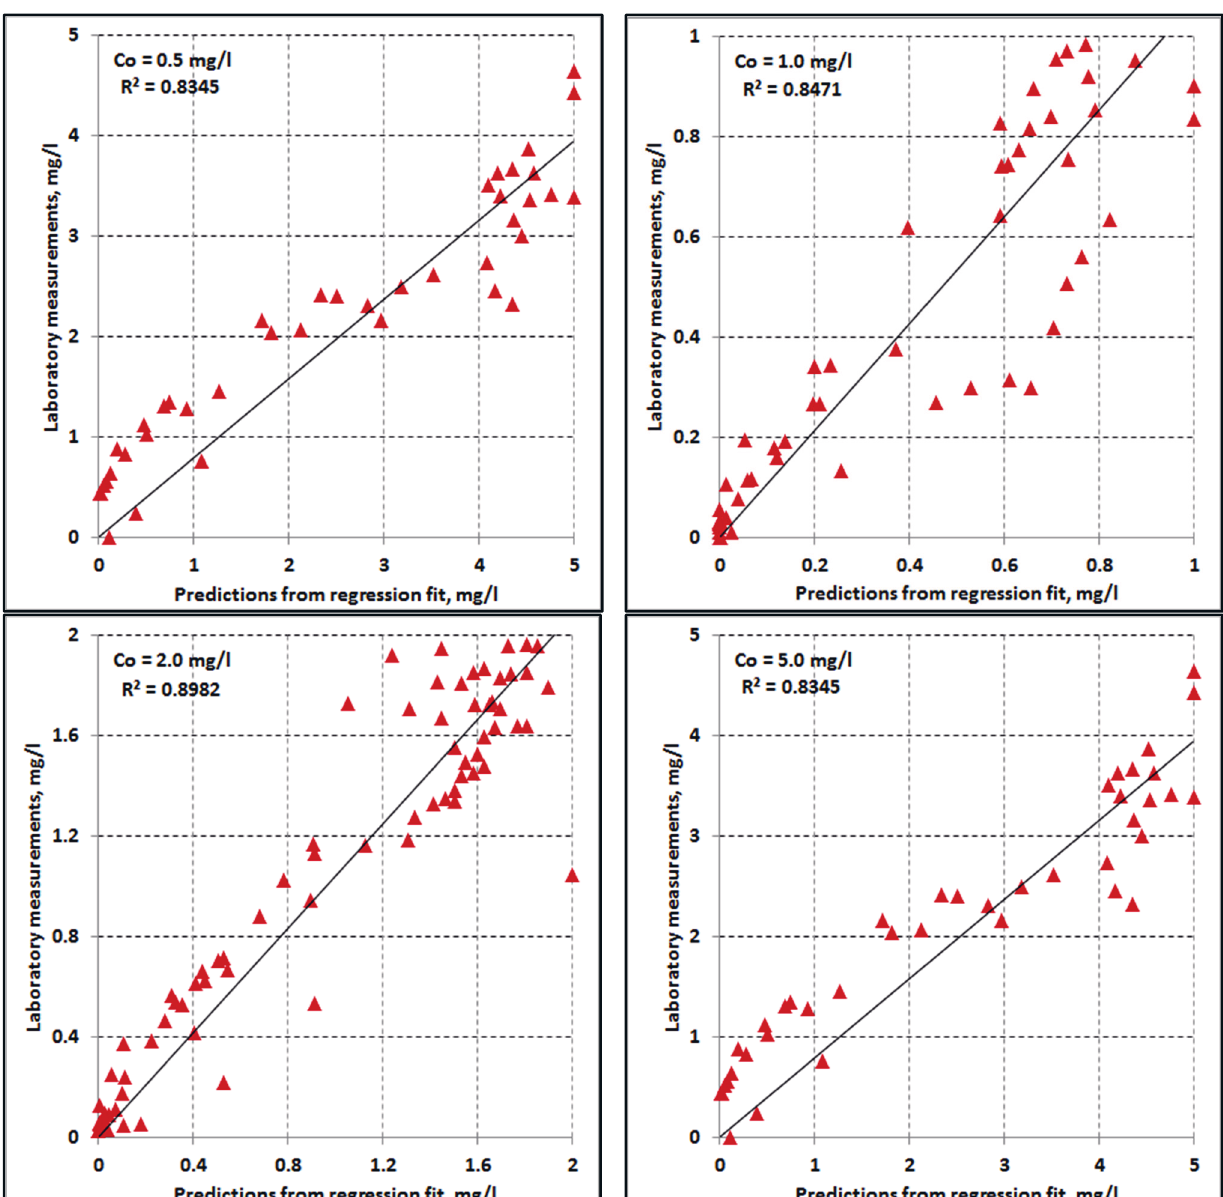
Figure 7. Correlation between observed and multivariate regression predicted chlorine decay at different chlorine dosages for all temperature